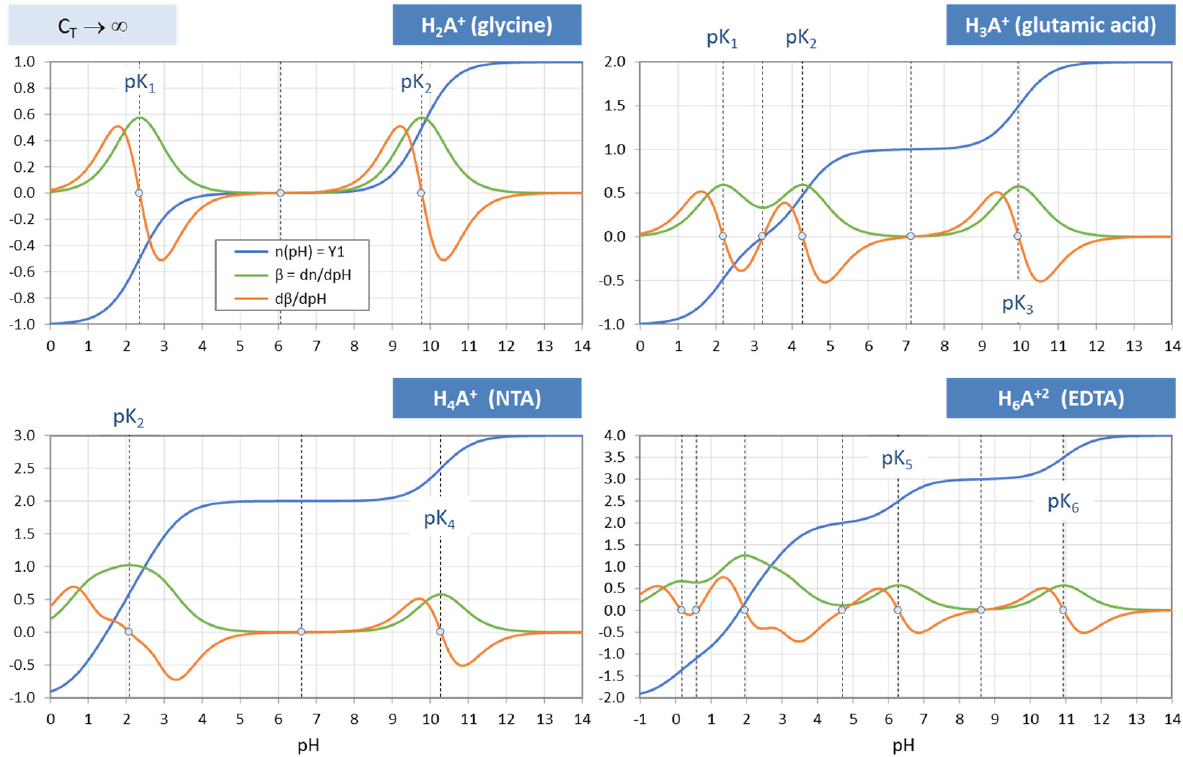
Figure 37. Titration curves n(pH), buffer capacity β and its derivative d β /dpH for four zwitterionic acids (from Table 12). Calculations for C T → ∞ .